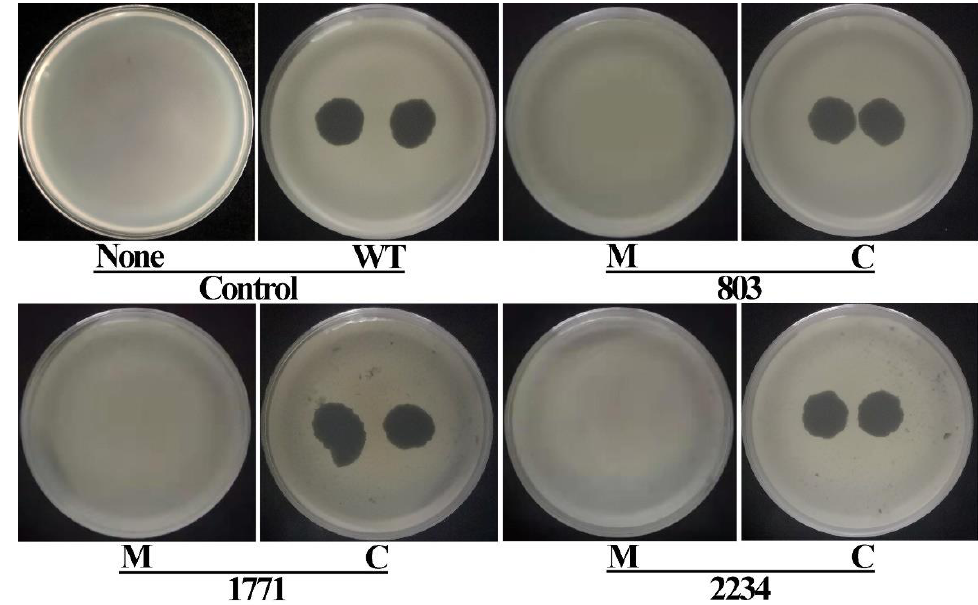
Figure 4. Verification of phage resistance by constructing the knockout mutants and complemented strains of the corresponding location genes of the 3 Tn5 mutants M488, M722 and M1070. WT: Wild type (+phage); None: wild type (-phage); M: Knockout mutant; C: Complemented strains.